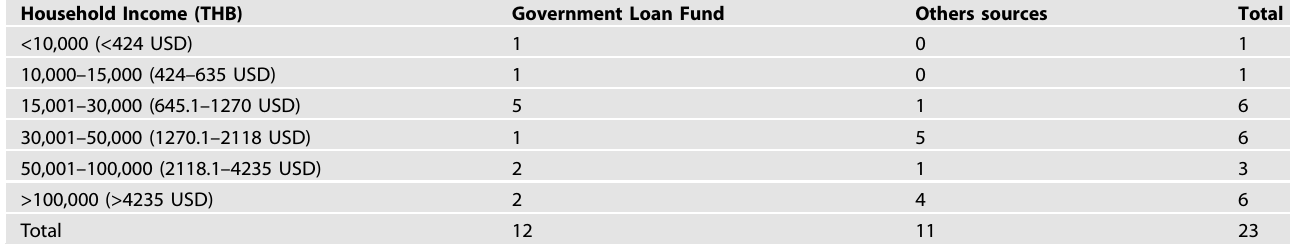
Table 2. Sources of Financial Support by Household Income ( N = 23).